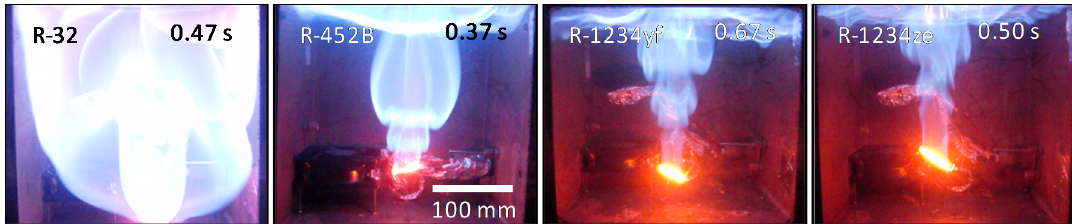
Figure 2. Images of ignition tests of stoichiometric mixtures with resistively heated wires. Images correspond to the largest flame for each test. The times shown are elapsed times after the onset of flaming. A video of these tests is provided in the Supplementary Materials Video S2.